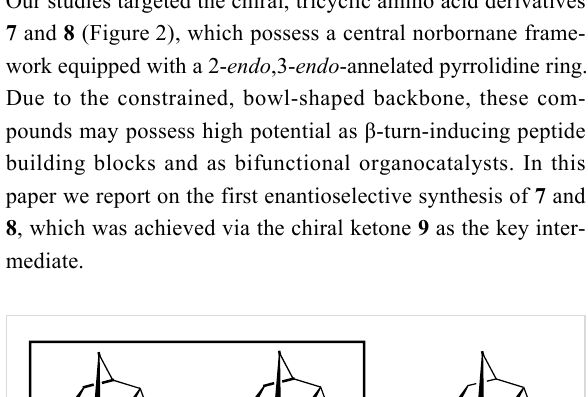
Our studies targeted the chiral, tricyclic amino acid derivatives 7 and 8 (Figure 2), which possess a central norbornane frame- work equipped with a 2- endo ,3- endo -annelated pyrrolidine ring.